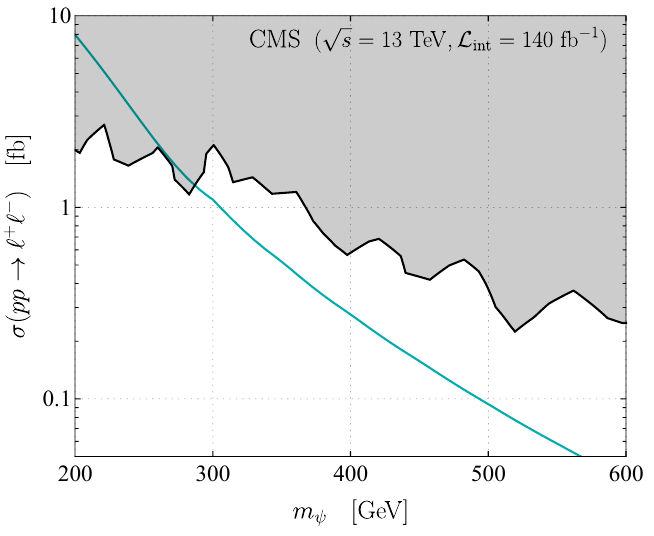
Figure 4 . The total cross-section (green curve) for the signal channel pp → ‘ + ‘ − , with ‘ = e, µ , as a function of m . The grey region is excluded by a 13 TeV CMS search with 140 fb − 1 ψ